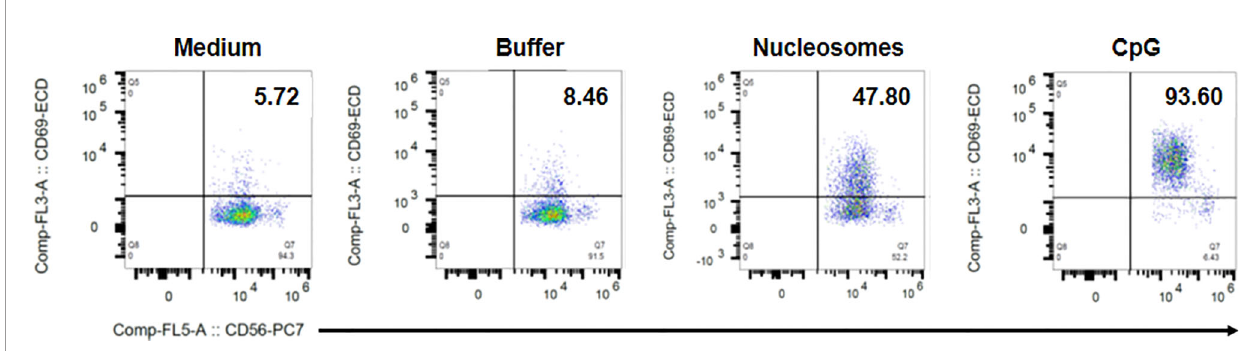
FIGURE 8 | Representative fl ow cytometry dot plots showing nucleosome-induced CD69 up-regulation by NK cells in PBMC. PBMC were isolated from a healthy donor and cultured without K562 cells in medium alone, the nucleosome puri fi cation buffer, puri fi ed nucleosomes (25 µg/ml) or a TLR9 agonist (synthetic oligonucleotide containing unmethylated CpG motifs, CpG). Cells were gated on NK cells (CD3 - CD56 + cells) as in Supplementary Figure 2 . Dot plots depict CD56 staining (x axis) versus CD69 staining (y axis). The percentage of CD69-positive cells among NK cells is indicated for each condition in the upper right quadrant. Shown is one representative experiment of six independent experiments using different donors and fi ve independent